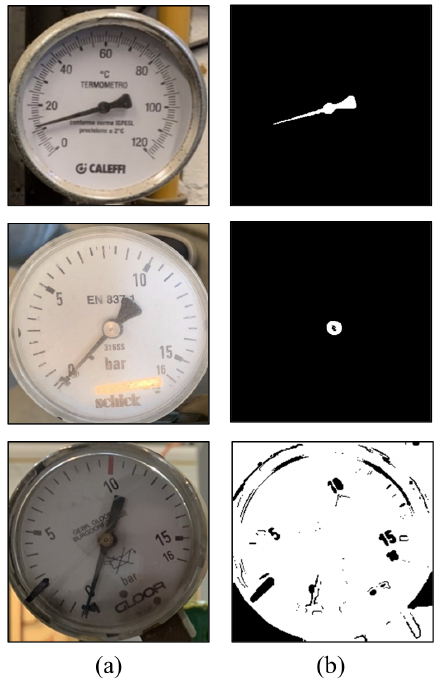
Figure 9. Application of different Binarization techniques. ( a ) Original image, ( b ) Otsu method, ( c ) adaptive threshold.